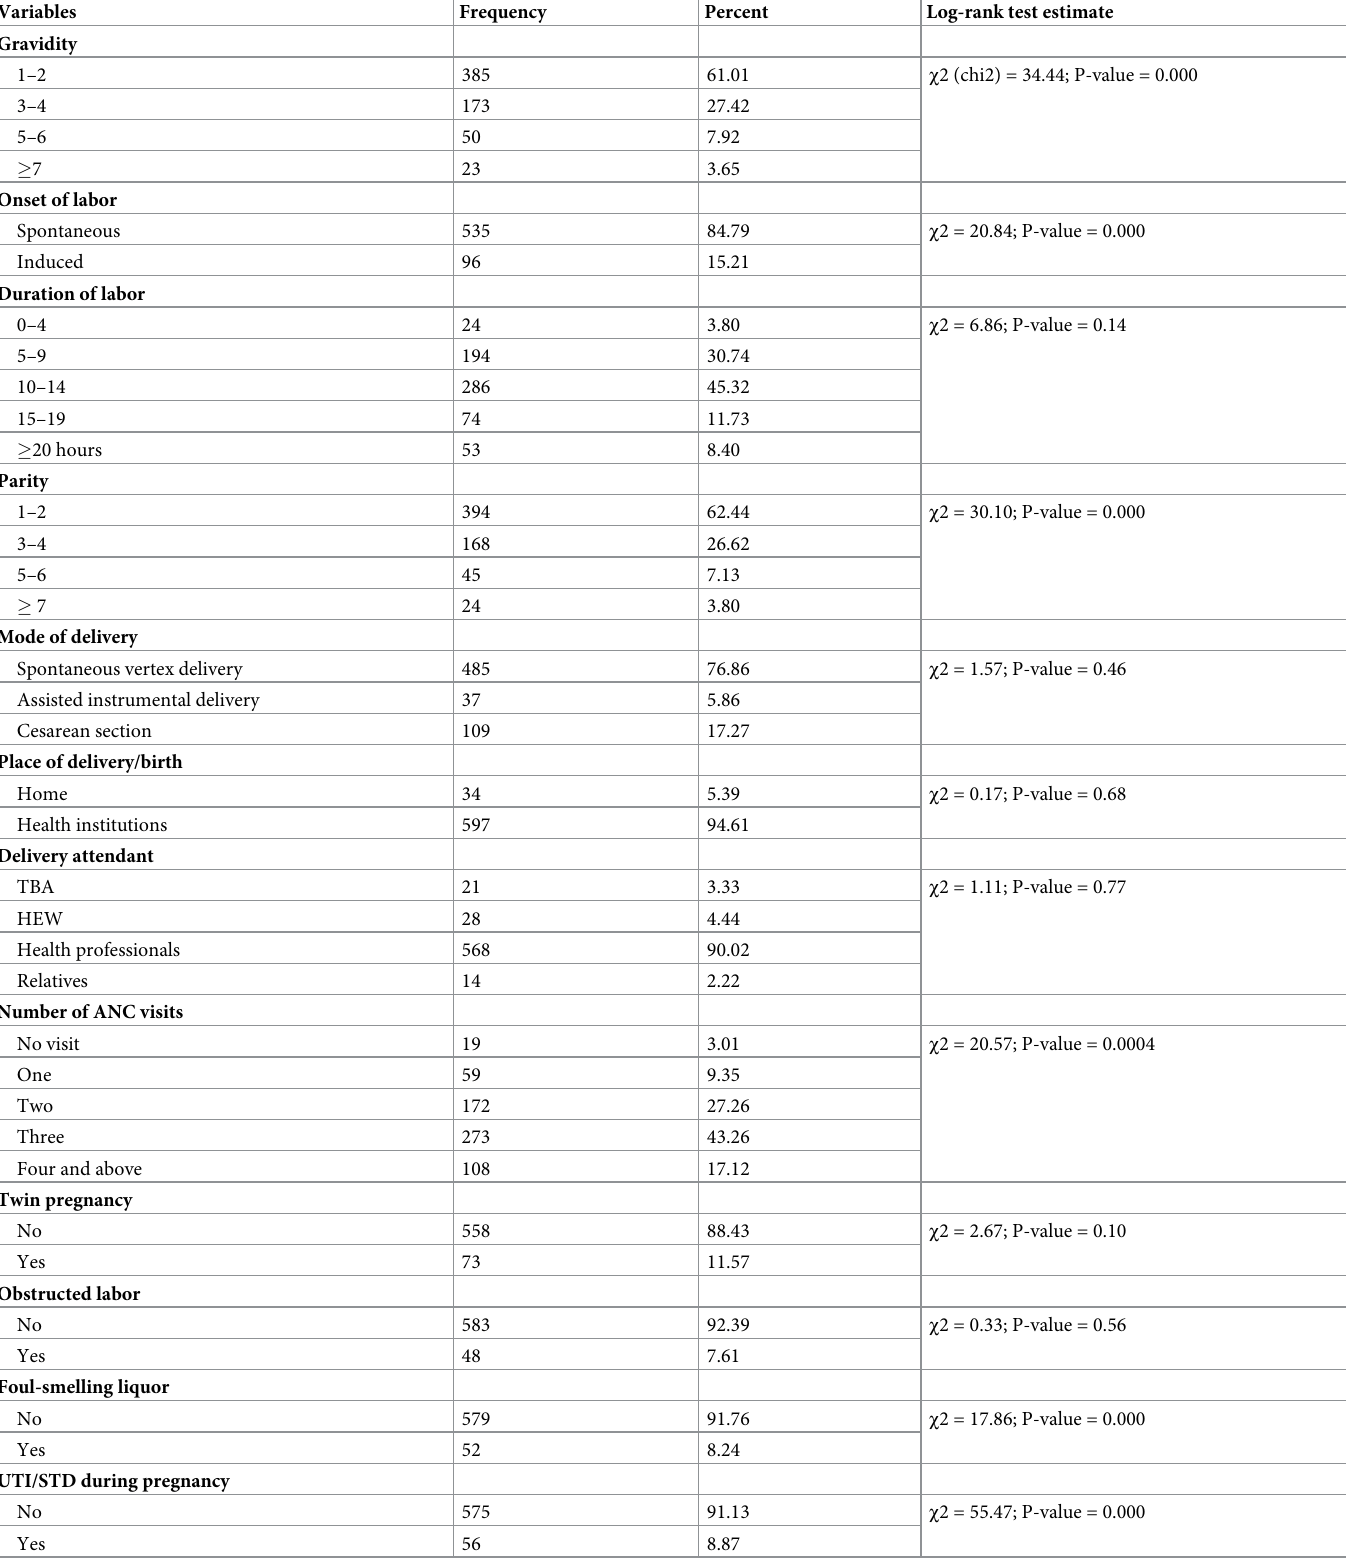
Table 2. Maternal-related characteristics in Public Hospitals of Central Gondar Zone, 2021 (n =